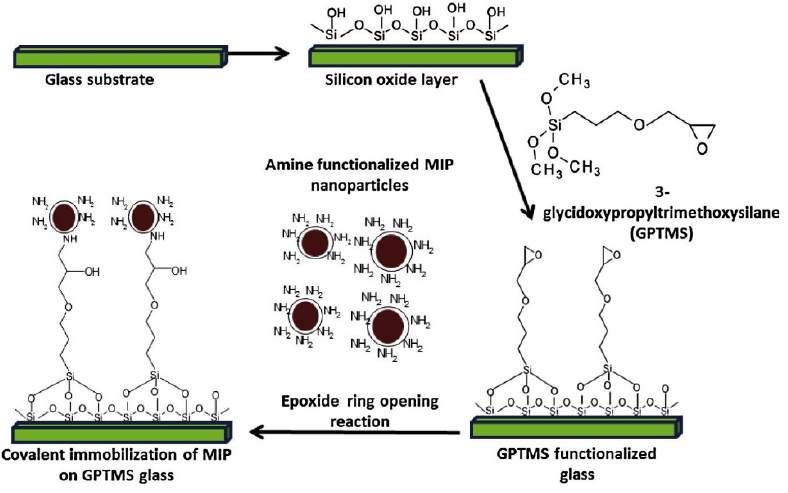
Figure 3. Process of immobilization of core–shell MIP nanoparticles. Reprint from Elsevier [134].